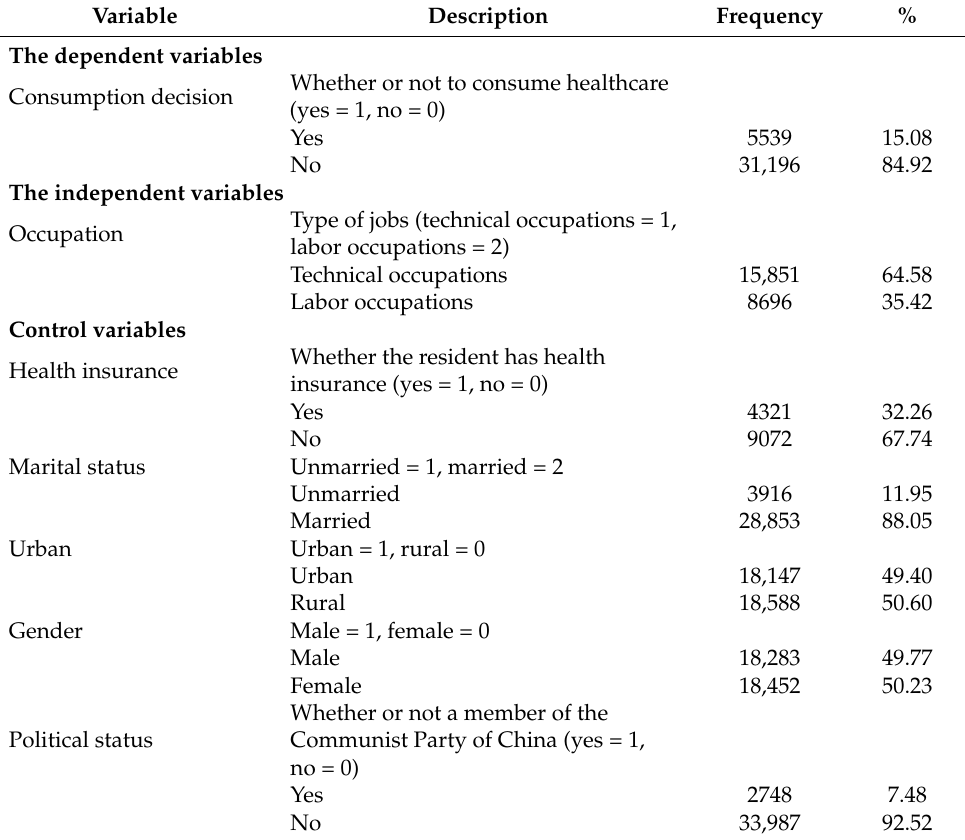
Table 2. Descriptive statistical results of category